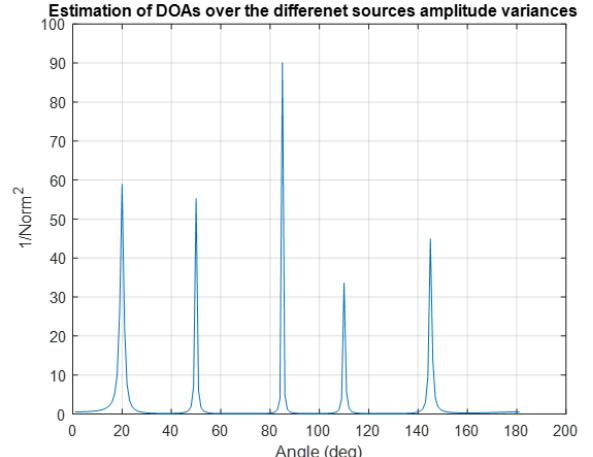
Figure 2. DOA Estimation for SNR = 0 db, Snapshot Number = 100, P = 5 and DOA = [20°; 50°; 85°; 110°; 145°] (different source amplitude variances).